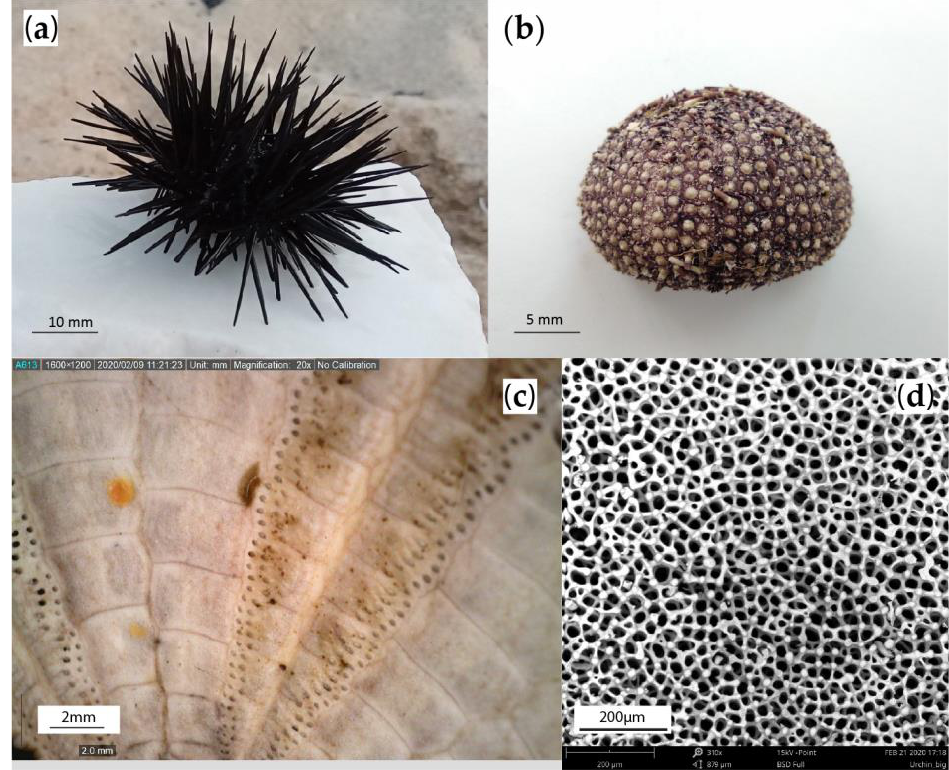
Figure 2. Overview of a sea urchin’s (Paracentrotus lividus) structure: ( a ) photograph of a fresh urchin; ( b ) dried urchin test with its spikes removed; ( c ) the plates of the sample under optical microscopy; ( d ) scanning electron micrography of the sample’s stereom.